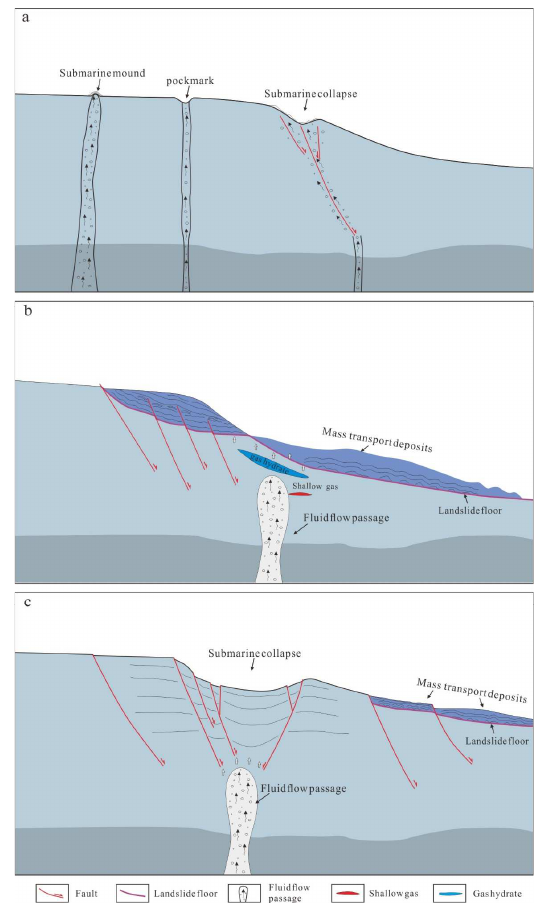
Figure 8. The model of potential geological hazards in the southern margin of the South China Sea as follows: ( a ) Submarine mounds, pockmarks, and small submarine collapses with columnar fluid flow passage and/or faults; ( b ) Large-scale mass transport deposits with potential gas hydrate, shallow gas and fluid flow passage below; ( c ) Large-scale submarine collapse with fluid flow passage below and small mass transport deposits.